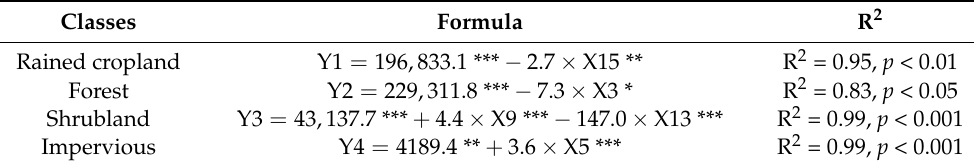
Table 6. Multivariate linear stepwise regression results of the area of land use types and driving factors. Classes Formula R 2 Rained cropland